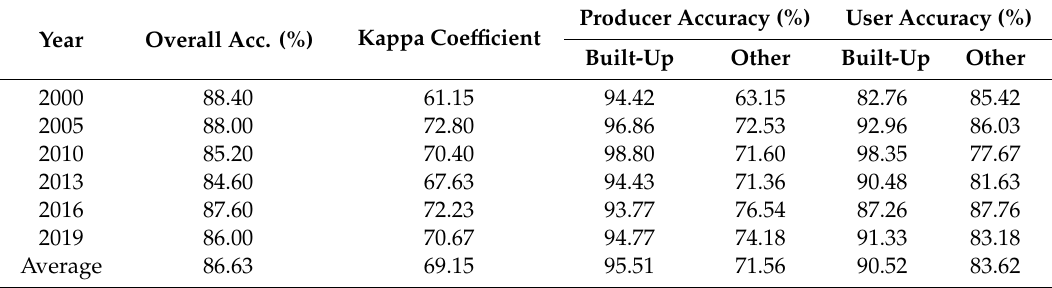
Table 3. Accuracy assessment and validation based on confusion matrix